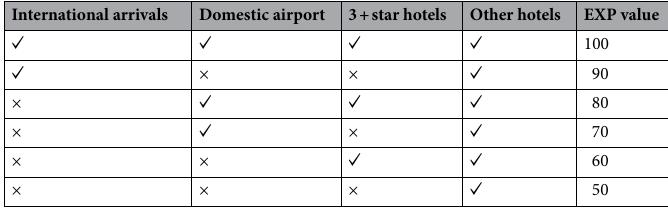
Table 7. Exposure values for the combination of different